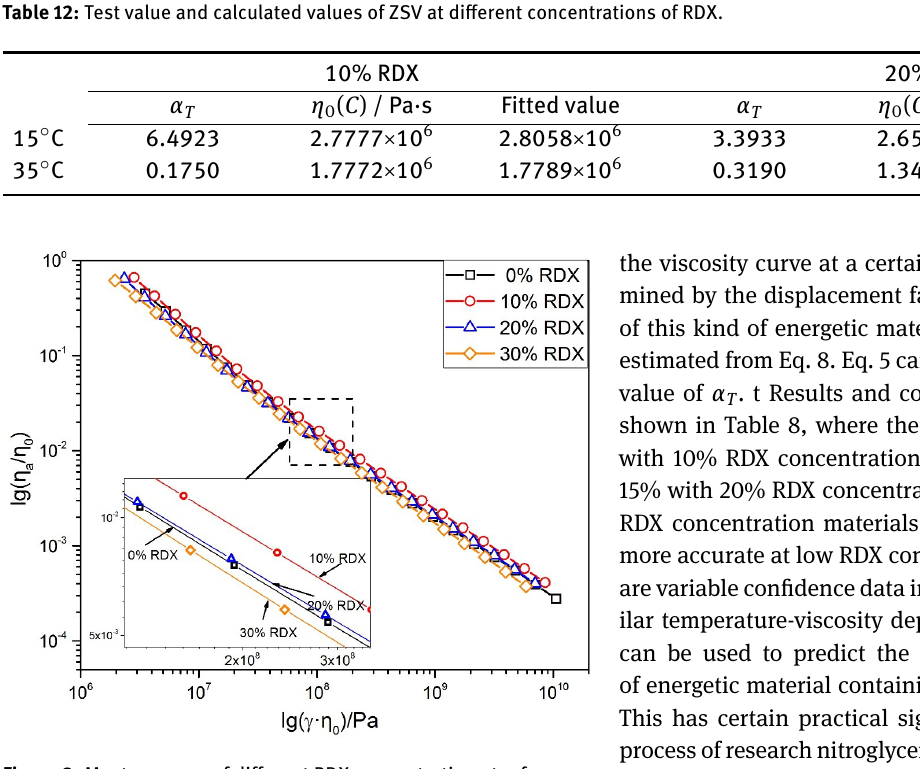
Figure 8: Master curves of different RDX concentration at reference temperature is 25 ∘